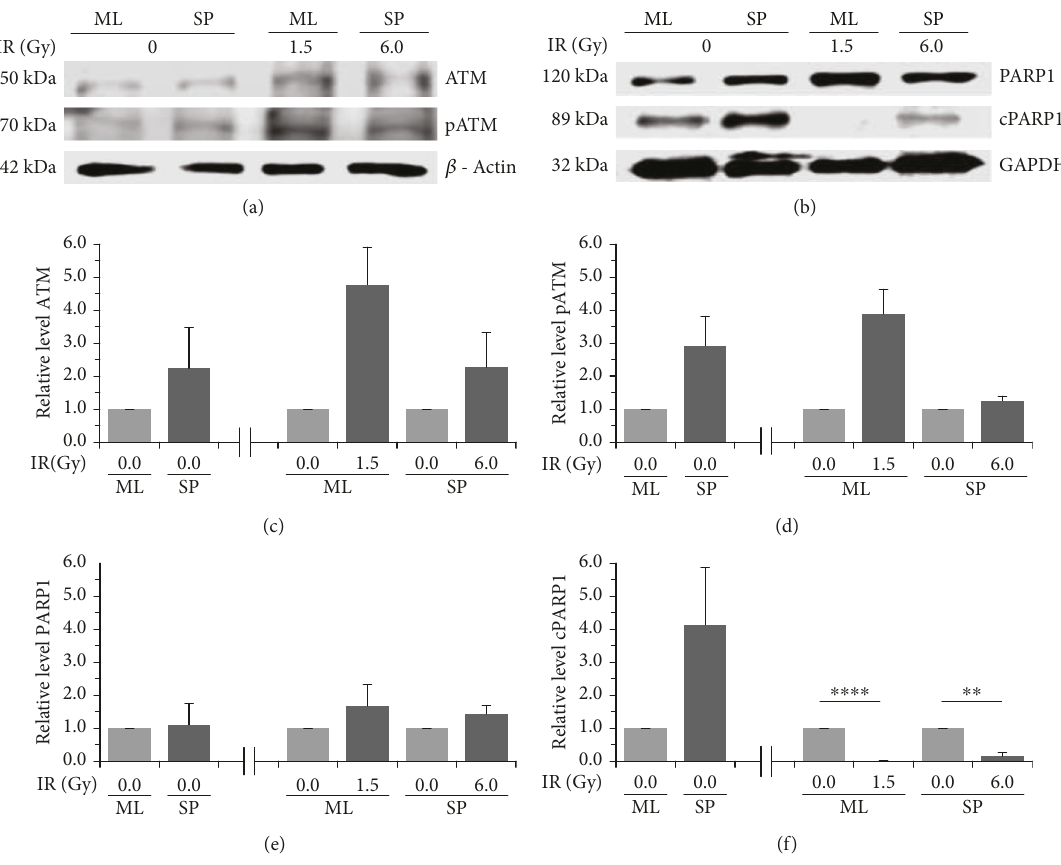
Figure 3: ATM and PARP1 are present and activated in cancer stem cells before and after ionizing radiation. (a) Representative immunoblot showing overall expression of ATM and phospho ATM (pATM) in SP and ML cultures before and 3h after exposure to ionizing radiation (IR). (b) Representative immunoblot showing overall expression of PARP1 and cleaved PARP1 (cPARP1) in HeLa SP and HeLa ML cultures before and 3 h after exposure to IR. (c) HeLa SP cultures had a higher level of ATM protein than HeLa ML cultures without exposure to IR. After exposure to IR, ATM expression increased in both cultures. (d) HeLa SP cultures had a higher level of pATM than HeLa ML cultures without exposure to IR. After exposure to IR, only HeLa ML cultures had an increase of pATM. (e) HeLa SP and HeLa ML cultures exhibited no di ff erences in the level of PARP1 protein before and after exposure to IR. (f) HeLa SP cultures had a higher level of cPARP1 than HeLa ML before exposure to IR. After exposure to IR, both cultures had a decreased level of cPARP1; however, HeLa SP continued to express cPARP1. β -Actin and GAPDH were used as loading control. The relative level of these proteins to β -Actin and GAPDH was analyzed by densitometry. The normalized level of proteins was expressed as mean ± standard error of the mean (SEM) at least two independent